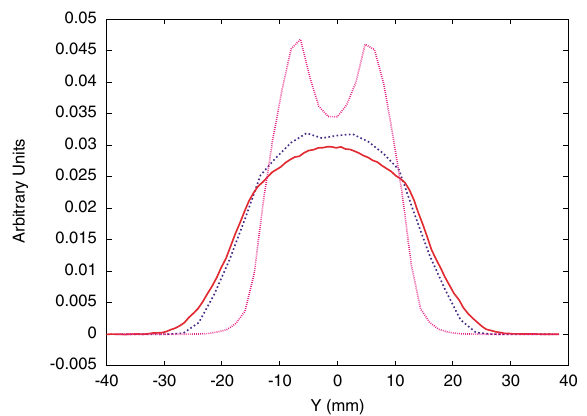
FIG. 2. (Color) Benchmark of longitudinal profile measure- ments with PIC simulations. The solid (red) curve is the experimental profile. The dashed (blue) curve is the PIC result with longitudinal space charge and impedance. The (pink) dotted line is the PIC result with longitudinal space charge but without other